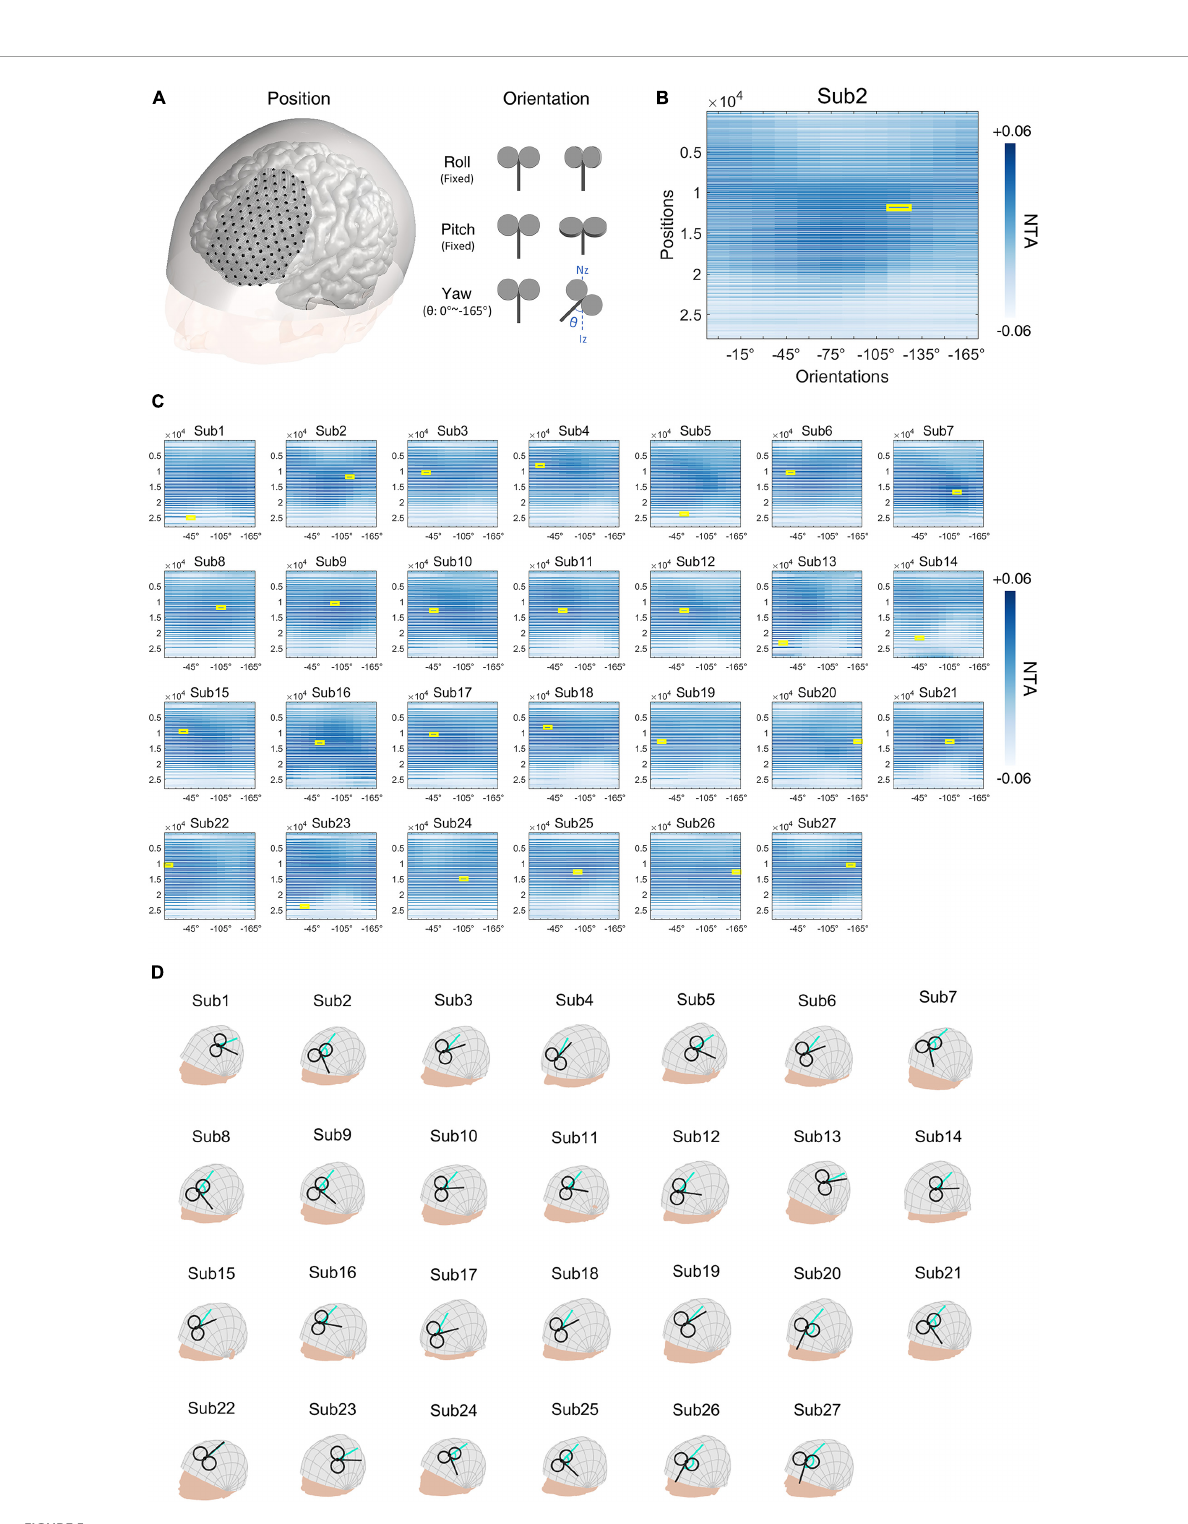
FIGURE5 Major depressive disorder (MDD) simulation experiment. (A) Illustration of positions and orientations of a representative individual. Large black dots represent 125 positions in the search space. For each position, 12 coil orientations, in the normal plane at the position (0 ◦ ∼− 165 ◦ , 15-degree intervals), were tested. Network targeting accuracy (NTA) was calculated for each pair of position and orientation. (B) NTA value distribution in the search grid. Each position in the 2-D grid represents a combination of position and orientation. (C) Maximum NTA was found in all patients (yellow border). Search space was interpolated from 125 × 12 to 27,977 × 12 for visualization purposes. (D) The optimal transcranial magnetic stimulation (TMS) coil placements are shown in individual scalp spaces. The cyan arrow represents 0 ◦ at each